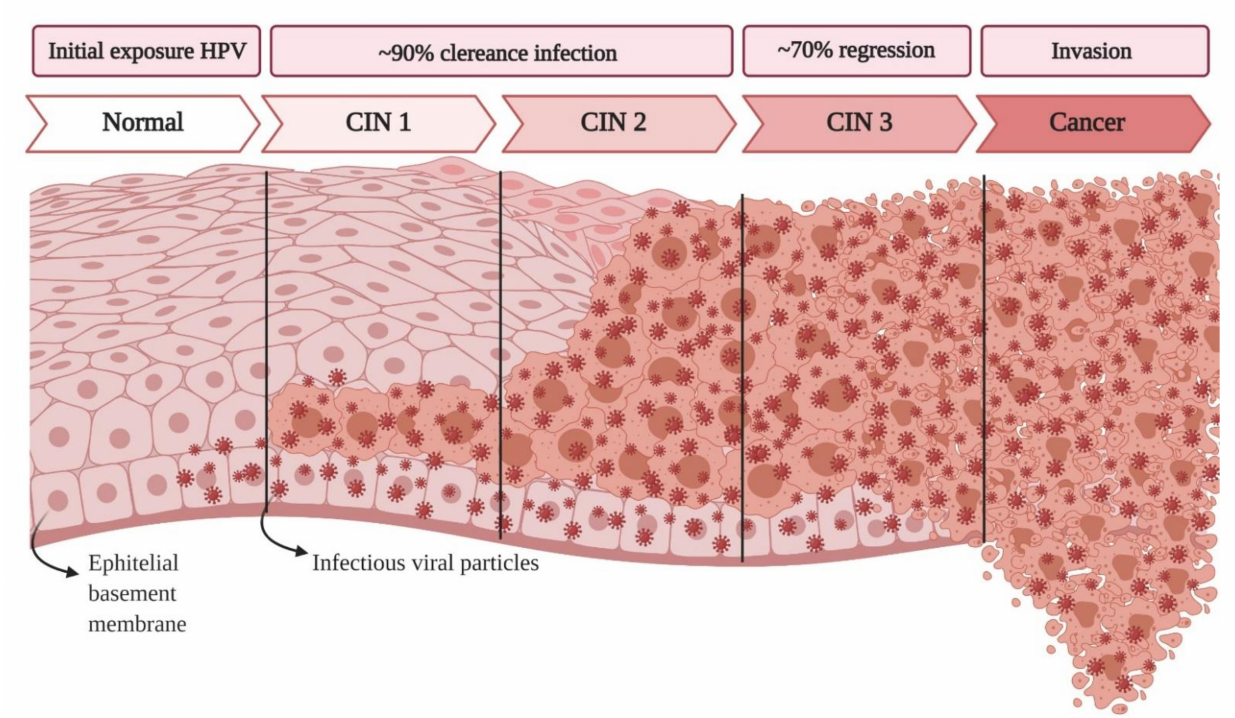
Figure 1. Classification of normal squamous epithelial cells and human papillomavirus (HPV) infections in normal precancerous lesions (cervical intraepithelial neoplasia grades 1, 2, and 3 “CIN 1, CIN 2, and CIN 3”) and cervical